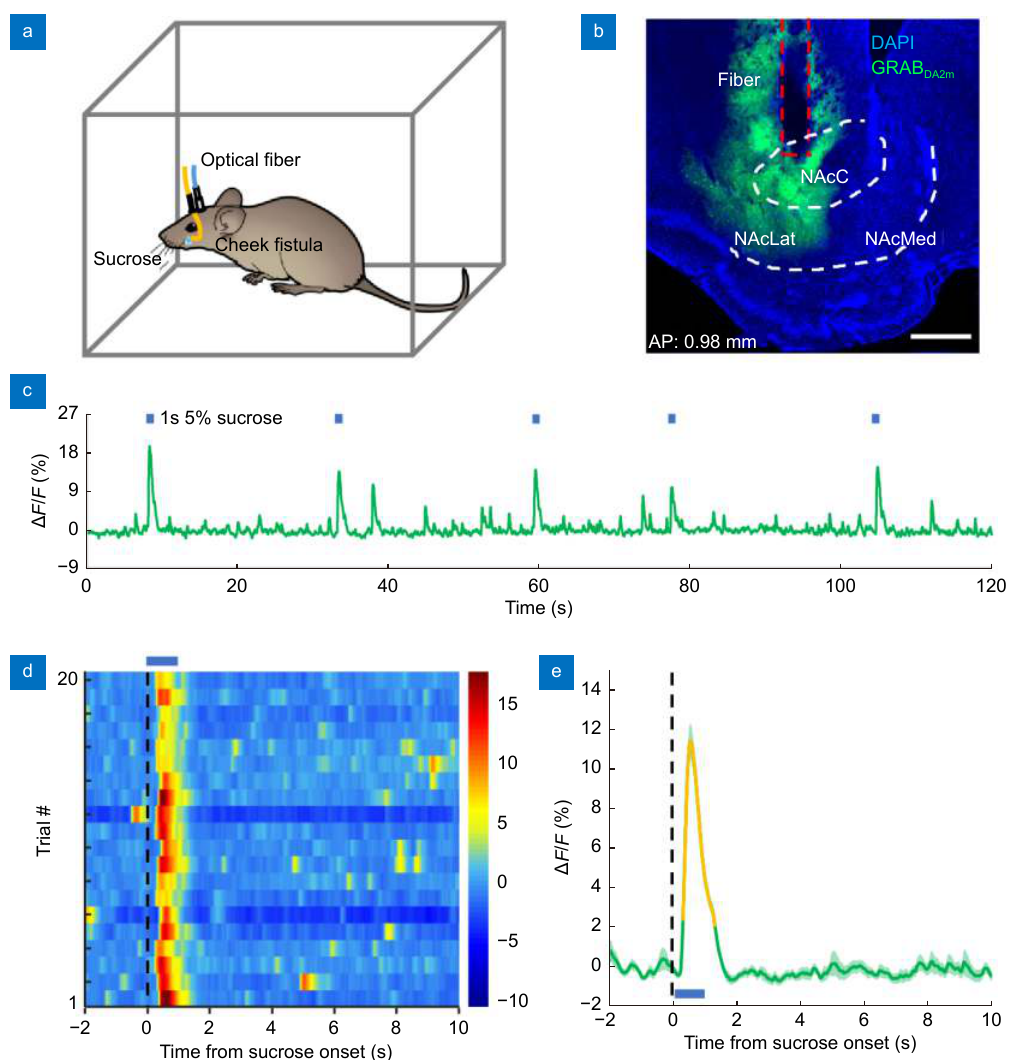
Fig. 4 | Real-time recording of DA dynamics in the NAcC of a freely moving mouse. ( a ) Schematic diagram of the setup for real-time record- ing of DA dynamics responses to intra-oral 5% sucrose solution delivery through a cheek fistula 3 . The sucrose solution was randomly infused for 20 trials in one behavioral session. ( b ) Histology confirming GRAB DA2m expression (green) in the NAcC brain region. GRAB DA2m : Ex 450 nm, Em 525 nm. The brain slice is 0.98 mm anterior to the bregma. Scale bar 500 μm. ( c ) Representative trace of DA signals (encompassing five se- quential trials) during the sucrose delivery experiment. The onset times of 5% sucrose solution delivery are indicated above the trace with blue bars. ( d ) Heatmap of DA signal transients aligned to the onset time of sucrose solution delivery. Each row in the heatmap indicates the data for one behavioral trial; 20 trials are plotted. ( e ) Averaged DA signal transients in response to sucrose solution delivery. The shaded area represents ±SEM. The blue bar represents a 1 s sucrose delivery event. Orange segments indicate a statistically significant increase from the baseline (* P <0.05, Wilcoxon’s signed-rank test; n = 10 pairs, one mouse). Abbreviations: DA, dopamine; NAc, nucleus accumbens; NAcC, nucleus ac- cumbens core; NAcLat, nucleus accumbens lateral shell; NAcMed, nucleus accumbens medial